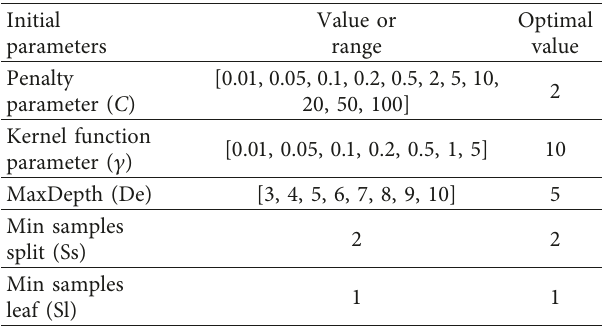
Table 9: Performance comparison with other ensemble models.